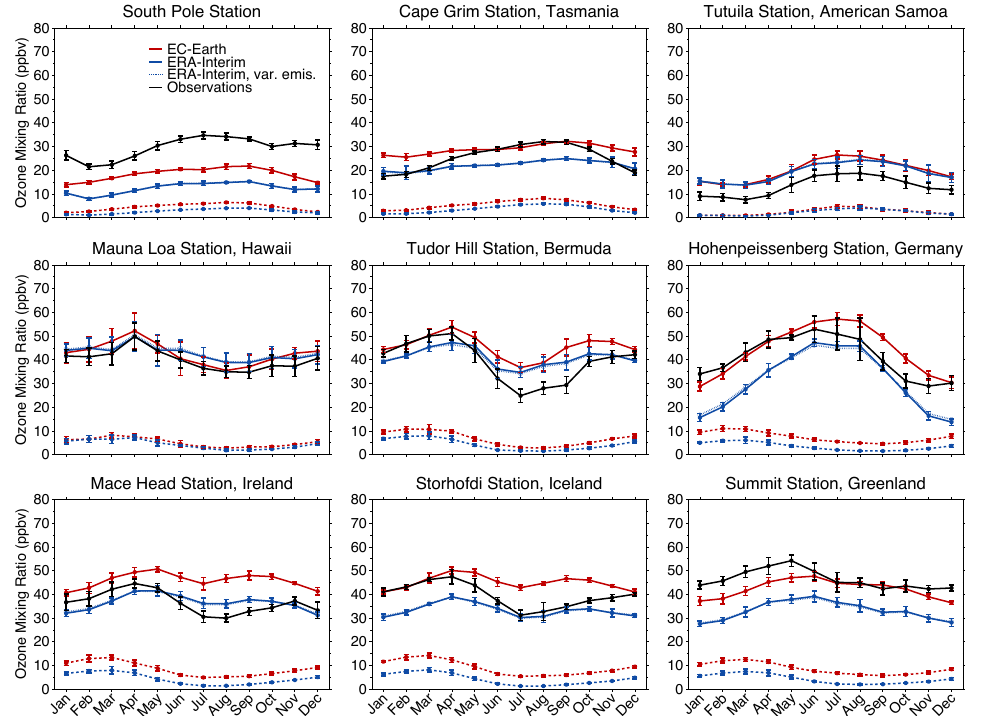
Figure 11. Comparison of monthly mean surface O 3 mixing ratios from the reference EC-Earth simulation (solid red lines) and the two ERA- Interim simulations (solid and dotted blue lines) against in situ measurements at a number of stations included in the NOAA GMD, WDCGG, and/or EMEP databases (solid black lines). The results from the ERA-Interim simulation with interannual variations in the emissions from anthropogenic activities and biomass burning (dotted blue lines) nearly coincide with those from the ERA-Interim simulation where these emissions are fixed to their values for the year 2000 (solid blue lines). The contributions from O 3S are shown by the dashed lines at the bottom of each panel (red for EC-Earth, blue for